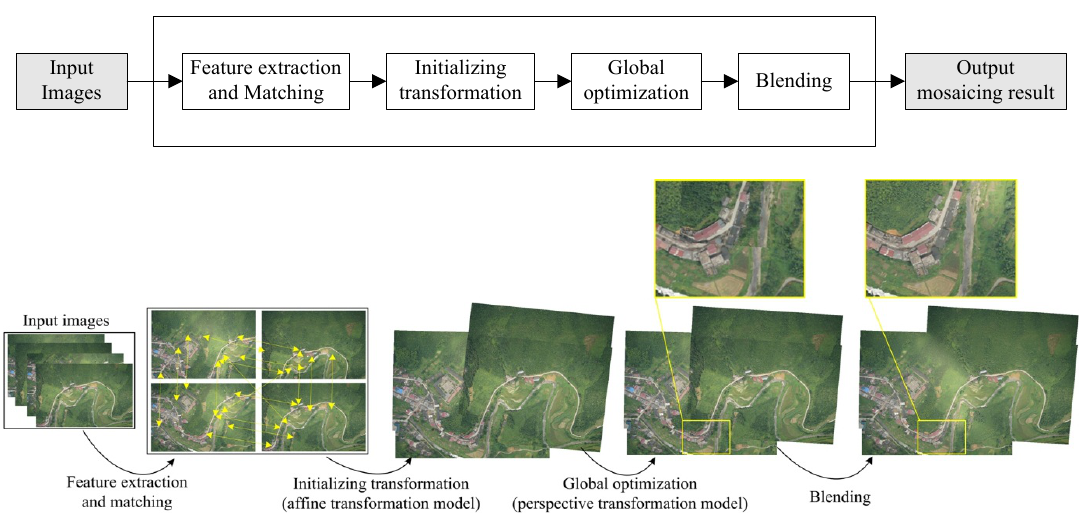
Figure 1. The pipeline for the proposed mosaicking algorithm.